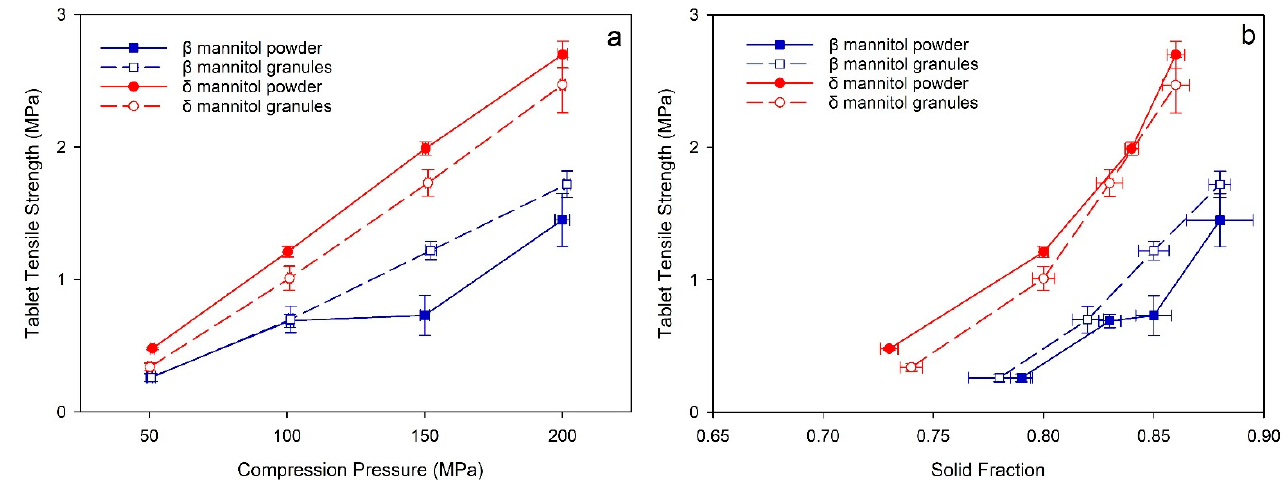
Figure 2. ( a ) Tabletability and ( b ) compactability plots of δ mannitol and β mannitol powder and granules. Arithmetic means of n = 10 ± S.D.